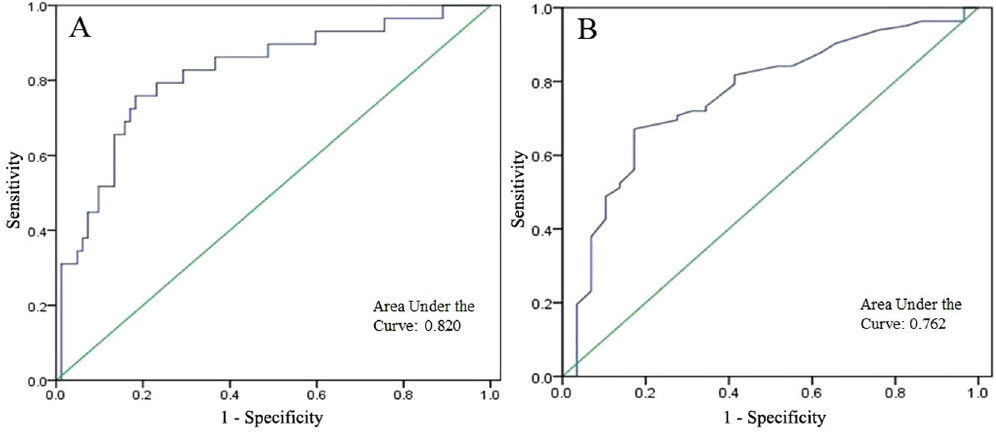
Figure 2. Receiver operating characteristic (ROC) curve analyses of apelin-12 ( A ) and age ( B ) as predictors of moyamoya disease